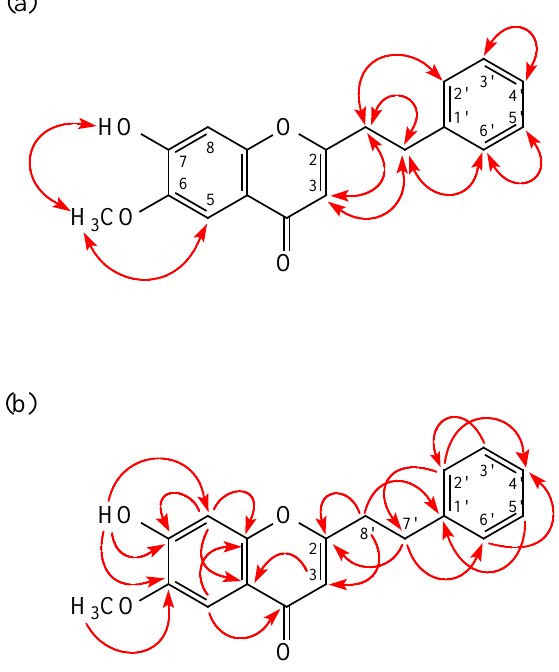
Figure 4. NOESY ( a ) and HMBC ( b ) correlations of 3